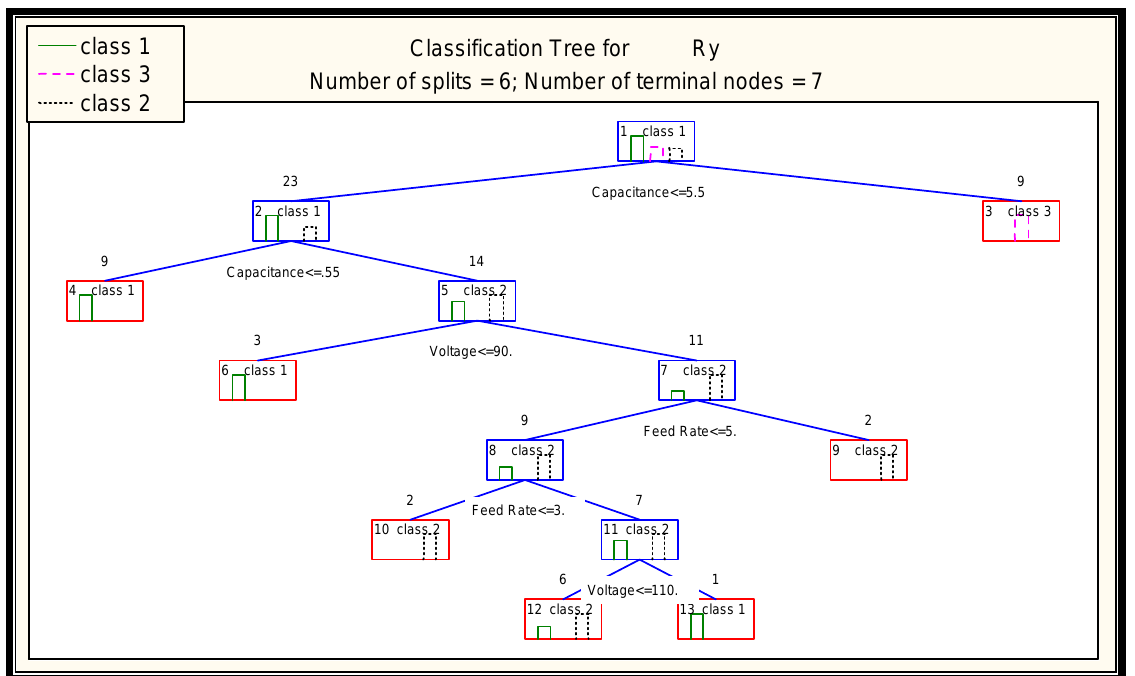
Fig. 4. Classification tree for prediction of Ry (three classes) ANOVA results for Ry values